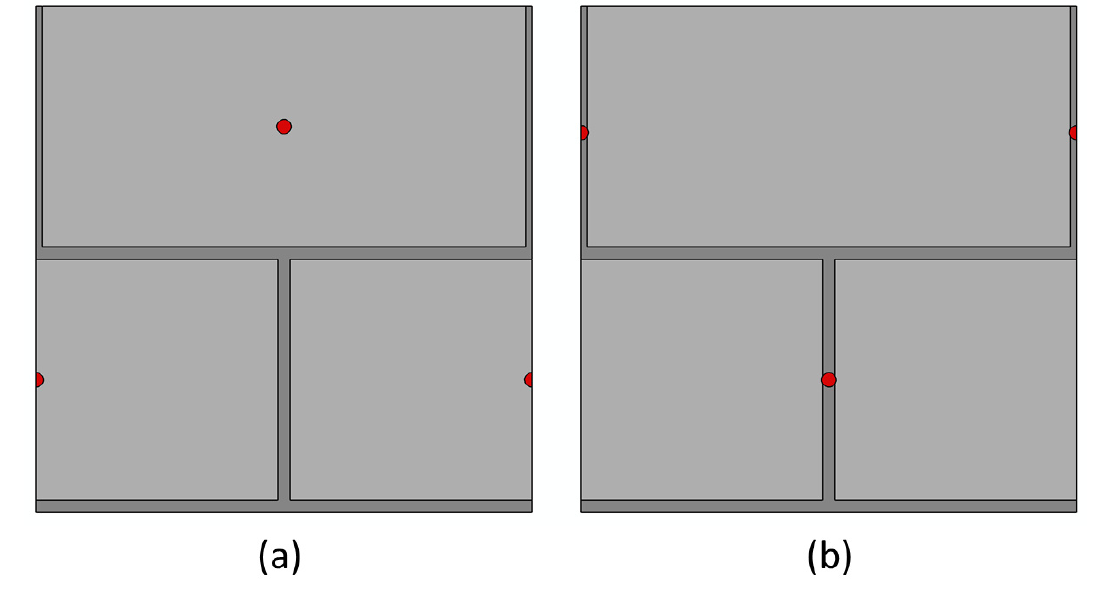
Figure 4. Fasteners at different ( a ) brick and ( b ) mortar locations. Table 6. Thermal conductivities and energy wasted by brick walls with metal fasteners at different locations.